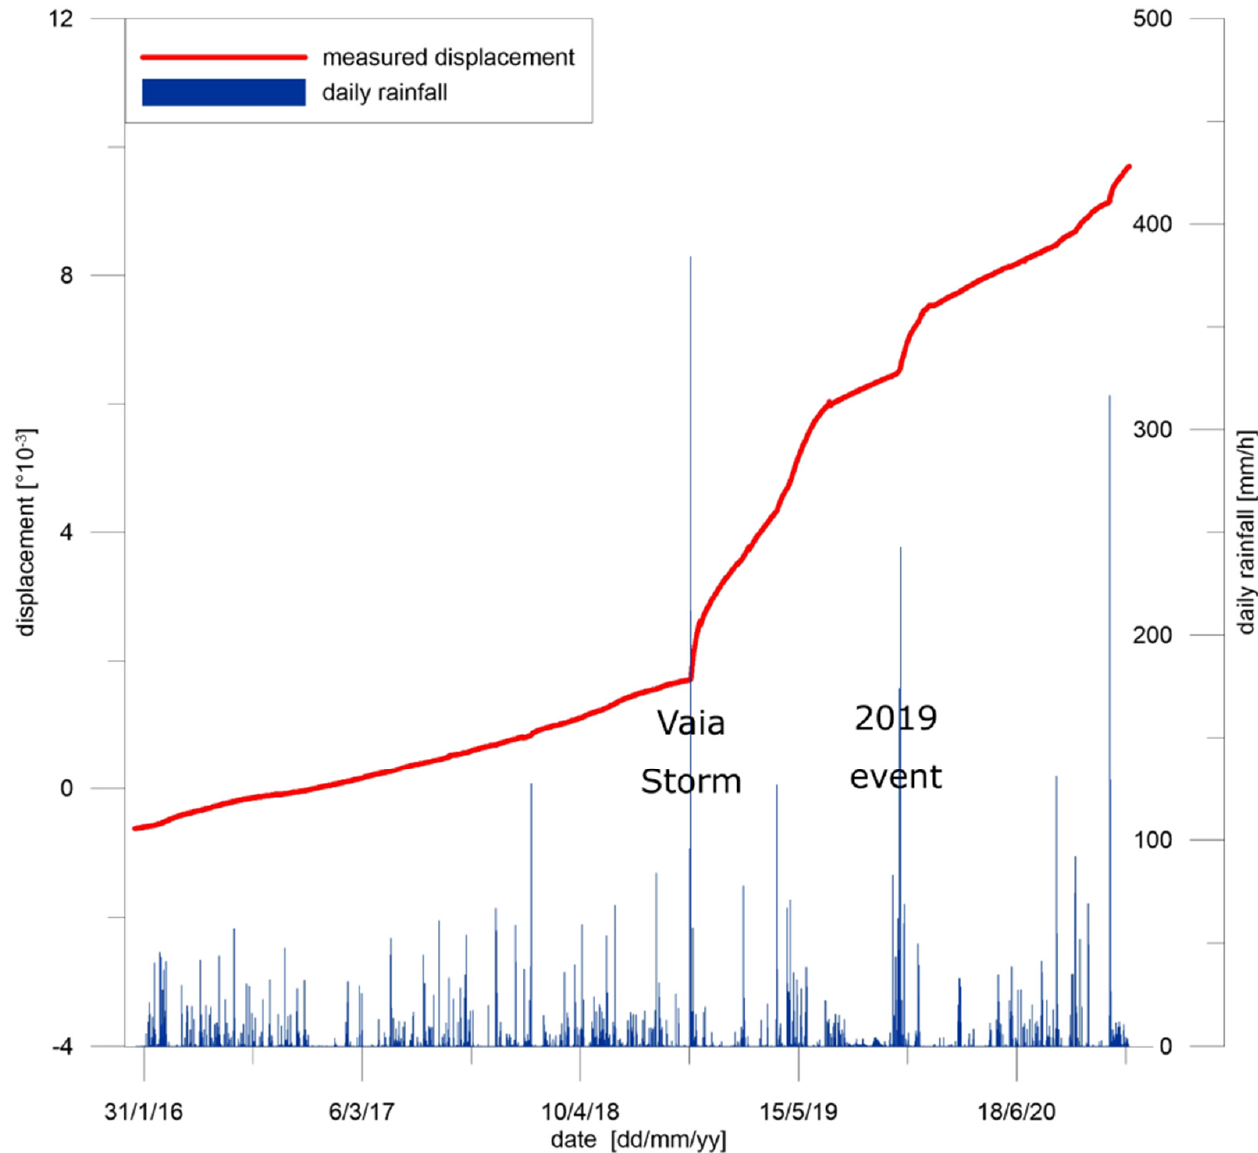
Figure 7. Data from the IPI I21Ter compared with the daily precipitation. These strong results, showing a long-term direct correlation between the Rio Verde discharge and the displacements, convinced the local authorities (Protezione Civile Friuli Venezia Giulia) to start the realization of remediation works based on the reduction in the flow discharge in the Rio Verde